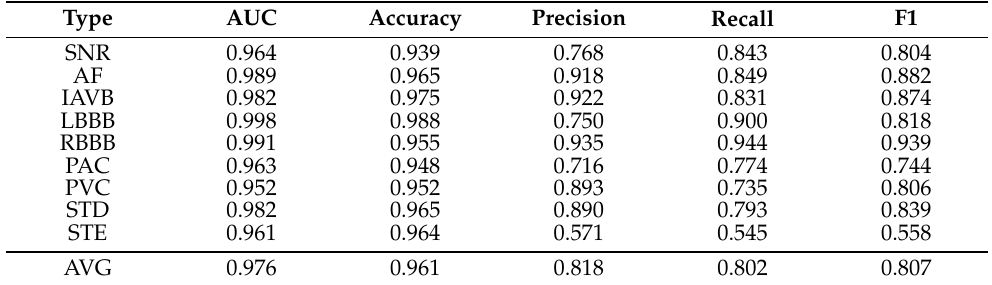
Table 11. Results produced by the proposed model without the Bi-GRU module on the CPSC2018 dataset. Type AUC Accuracy Precision Recall